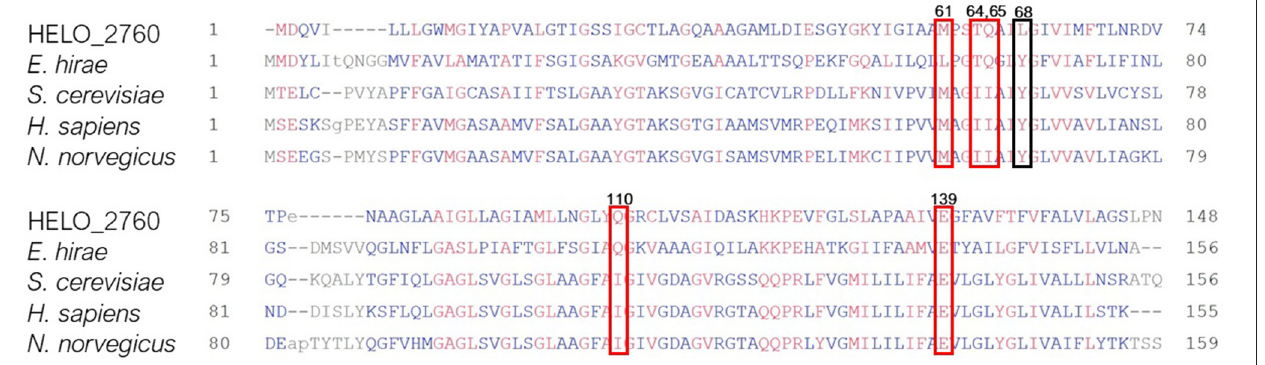
FIGURE 9 | Alignment of various V-type ATPase K subunits/translocating units for determination of the ion specificity in H. elongata . Used are the same sequences as in Murata et al. (2005) which elucidated the Na + -translocating activity in Enterococcus hirae . In contrast, the remaining sequences refer to H + -linked V-type ATPases. Marked are the essential residues for H + - and Na + -binding (Murata et al., 2005). H. elongata shows similarities with both